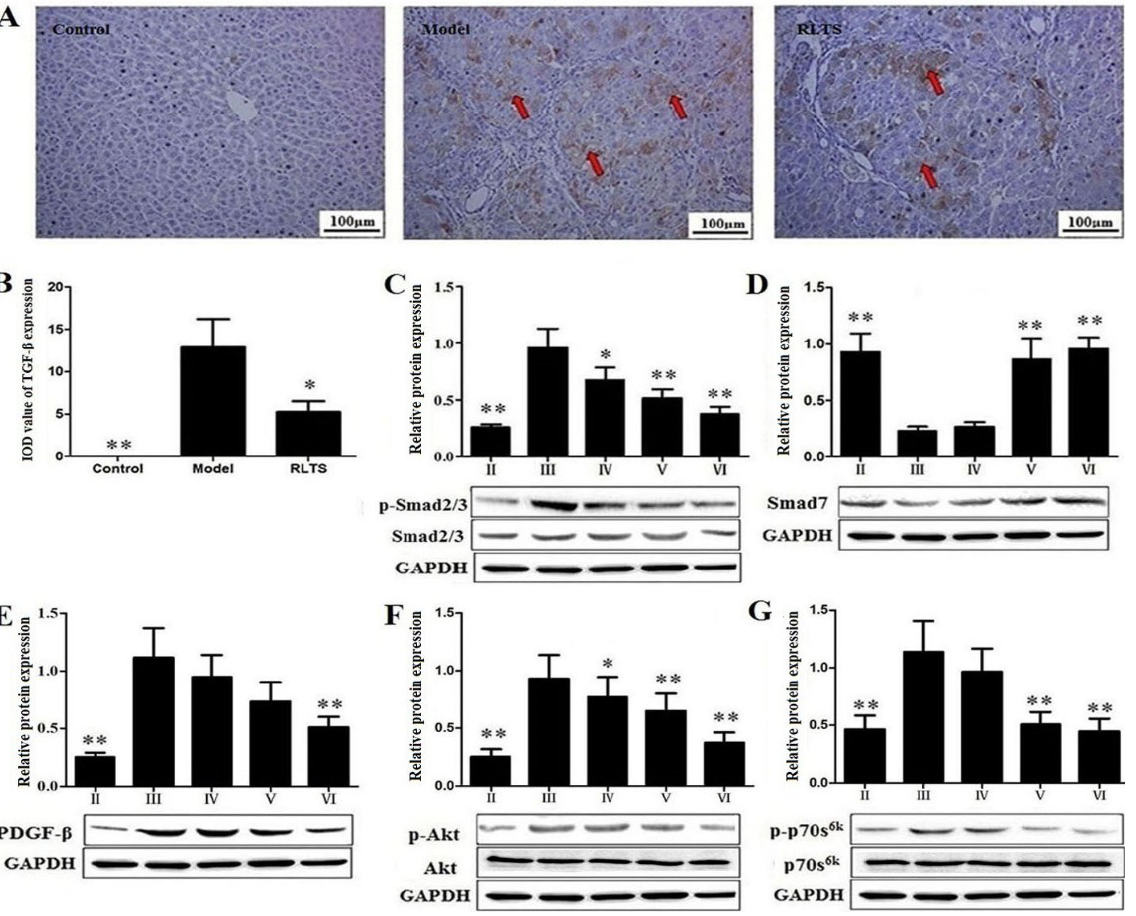
Figure 6. Effect of Rosa laevigata Michx fruit (RLTS) (210 mg/kg) on the expression of TGF-β1 based on immunohistochemical assay (magnification, 100×) ( A ); Statistical